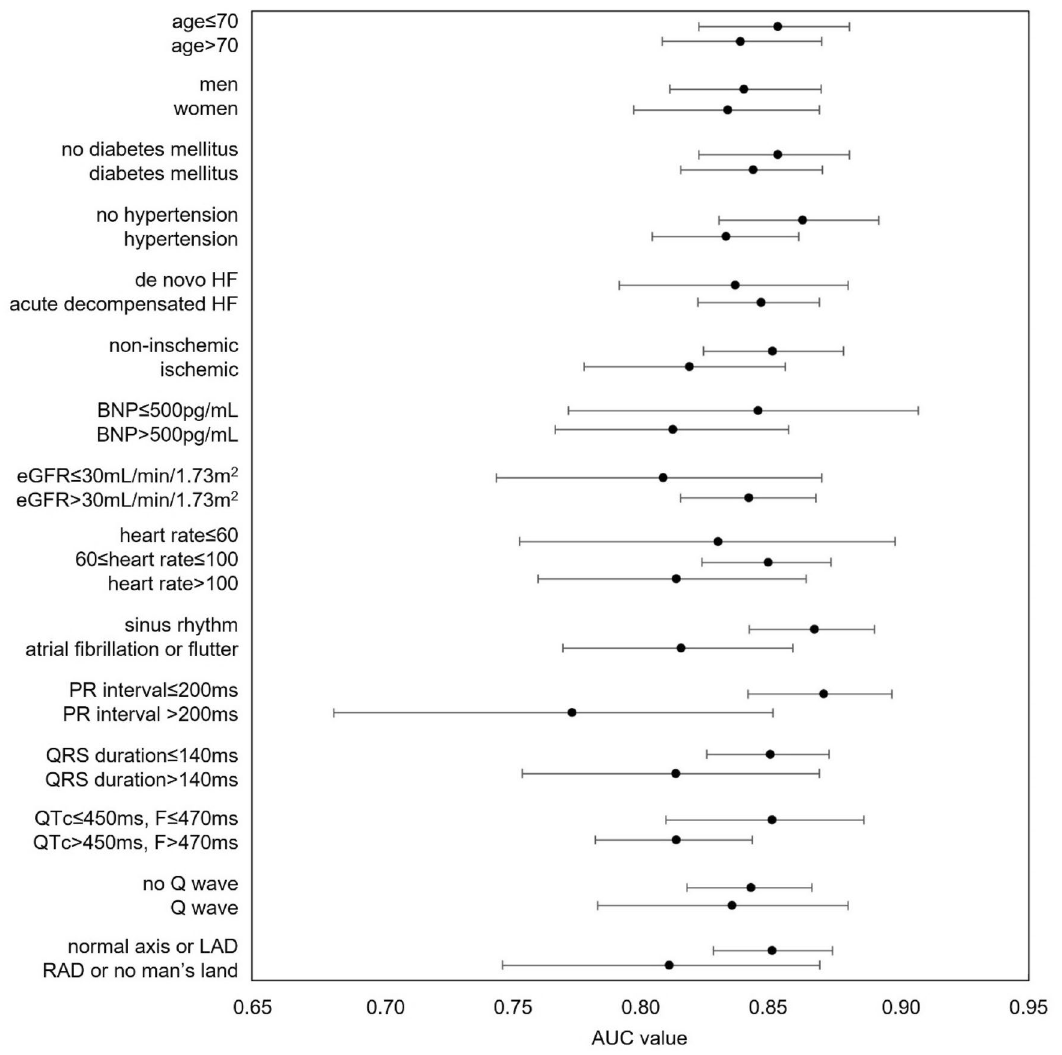
Figure 4. Forest plot depicting AUC values (95% confidence interval) of the DeepECG-HFrEF algorithm in identifying LVSD in different subpopulation . The forest plot of DeepECG-HFrEF algorithm showed similar performance among various clinical parameters. AUC area under the receiver-operator characteristic curve, BNP B-type natriuretic peptide, EF ejection fraction, eGFR estimated glomerular filtration rate, HF heart failure, LAD left axis deviation, RAD right axis